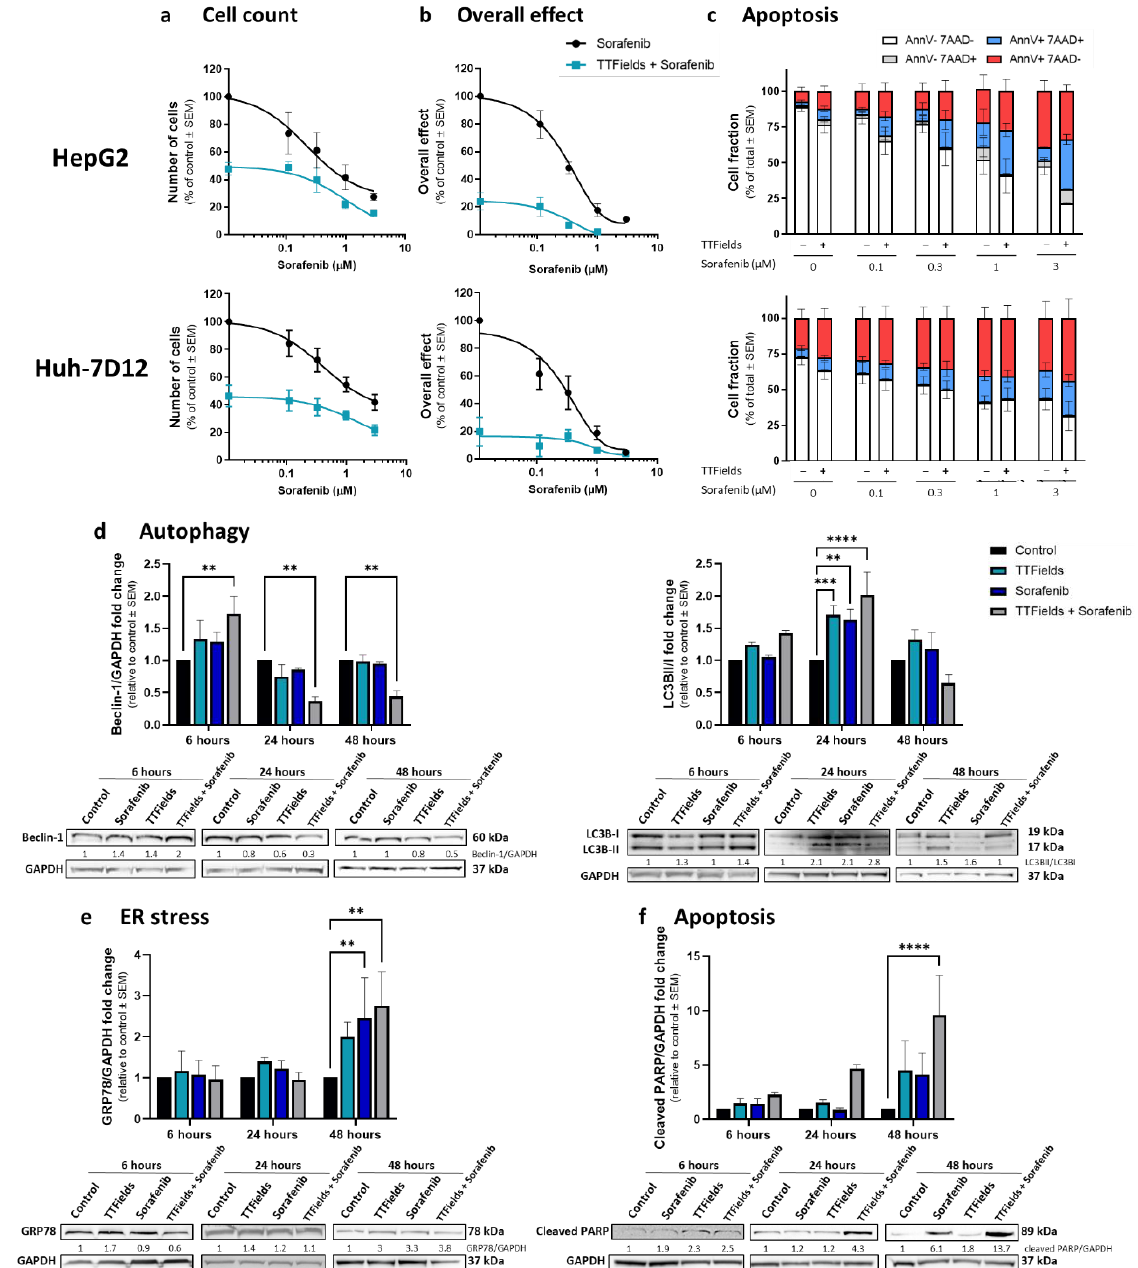
Figure 3. In vitro efficacy and mechanism of action of TTFields in combination with sorafenib. HepG2 and Huh-7D12 cells were treated for 72 h with various concentrations of sorafenib, alone or in combination with 150 kHz TTFields, followed by examination of cell count ( a ), overall effect ( b ), and apoptosis ( c ). Values are mean ( N ≥ 3) ± SEM. For the dose effect of sorafenib: p < 0.001 for cell count and apoptosis, and p < 0.005 for overall effect. For the effect of TTFields versus sorafenib alone: p < 0.001 for cell count and overall effect, p < 0.01 and p = 0.16 for apoptosis assay live cells in HepG2 and Huh-7D12 cells, respectively; two-way ANOVA. HepG2 cells were treated for 6, 24, or 48 h with 150 kHz TTFields, 3 µM sorafenib, or the two treatments combined, followed by Western blot ex- amination of the autophagy markers beclin-1 and LC3 ( d ), the ER stress marker GRP78 ( e ), and the apoptosis marker cleaved PARP ( f ). Values are mean ( N ≥ 3) ± SEM. ** p < 0.01, *** p < 0.001, and **** p < 0.0001 relative to time-respective control; two-way ANOVA. ANOVA = analysis of variance; SEM = standard error of the mean; TTFields = Tumor Treating Fields.